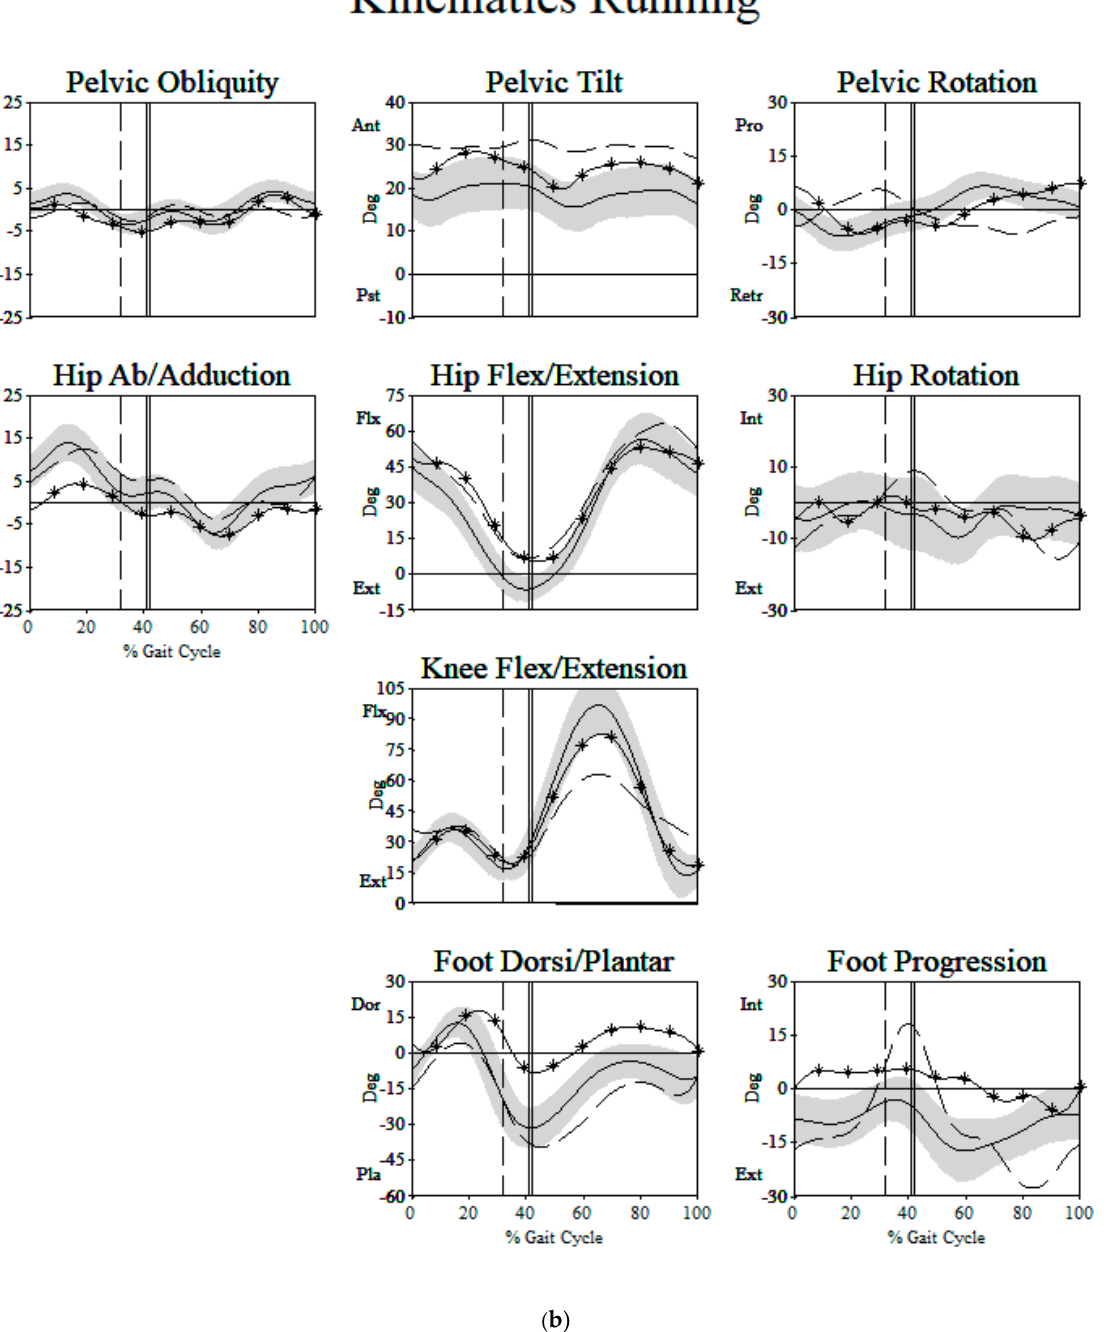
Figure A1. Two examples of children with cerebral palsy from the Erie Center (Subject 1 dashed line, Subject 2 solid line with * symbols) are shown compared to typically developing subjects average (solid black line) and standard deviation (gray band). ( a ) For walking, subject 1 had a GDI of 74 with deviations largely occurring in the sagittal ankle, knee, hip, and pelvis (with further deviations in all other kinematic variables). Subject 2 had a GDI of 99 with mild deviations from typically developing children. ( b ) For running, subject 1 had a greater GDI of 85 with deviations largely occurring in the sagittal knee and pelvis. Subject 2 had a lower GDI of 89 with deviations occurring in sagittal plane ankle, foot progression, and hip ab/adduction.